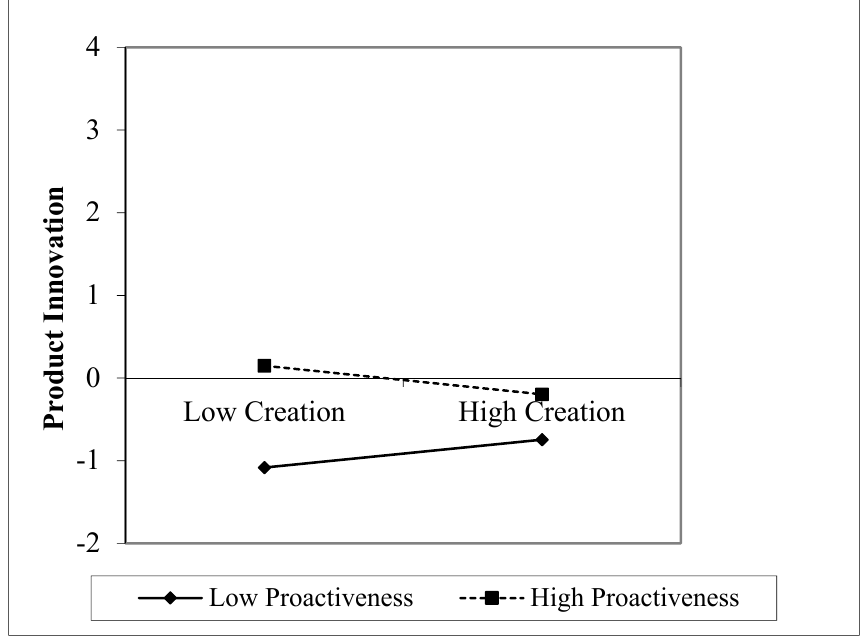
Figure 1. The moderating e ff ect of proactiveness on the knowledge creation–product innovation relationship. Source: Own elaboration.